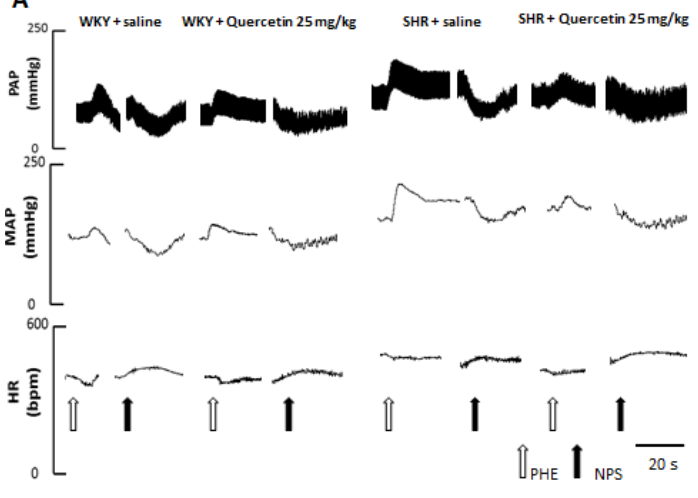
Figure 2. Baroreflex sensitivity test. Representative tracings of a rat from each group (WKY + saline, WKY + Quercetin 25 mg/kg; SHR + saline, SHR + Quercetin 25 mg/kg) illustrating the changes in pulse arterial pressure (PAP, mmHg), mean arterial pressure (MAP, mm Hg), and heart rate (HR, bpm) in response to phenylephrine (PHE, 8 μ g/kg—open arrows) and sodium nitroprusside (SNP, 25 μ g/kg—black arrows) ( A ). Determination of baroreflex sensitivity. Values for baroreflex gain (bpm/mmHg) determined by the modified Oxford method using bolus intravenous injection of vasoactive drugs sodium nitroprusside (25 μ g/Kg) and phenylephrine (8 μ g/Kg) in WKY + saline (n = 8, open bar), SHR + saline (n = 9, light grey bar); SHR + Quercetin 2 mg/kg (n = 7, medium grey bar); SHR + Quercetin 10 mg/kg (n = 8, dark grey bar) and SHR + Quercetin 25 mg/kg (n = 8, black bar) groups. ( B ). * p < 0.05, when compared to WKY + saline group and # p < 0.05, when compared to SHR + saline